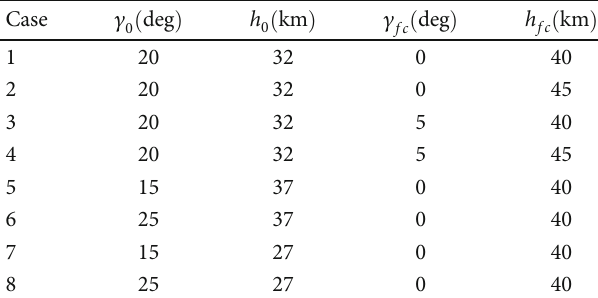
Table 6: Initial conditions and terminal constraints for di ff erent